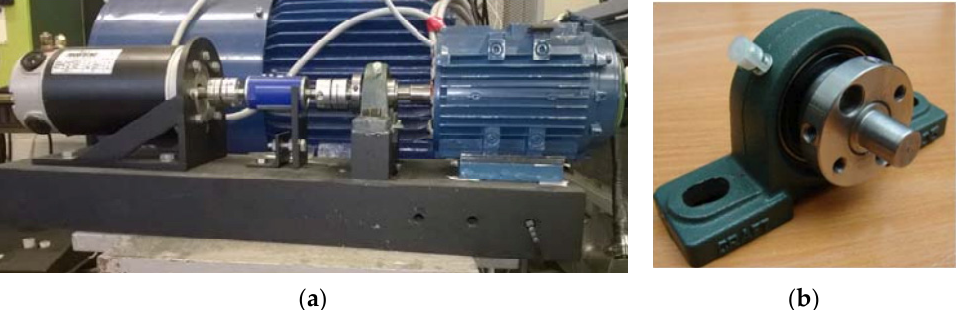
Figure 3. Test bench elements for eccentricity ( a ) Test bench with assembled switched reluctance motor on the right, also (from the left) DC motor, torquemeters, clutches and sleeve; ( b ) Sleeve with bearing support to cause eccentricity.